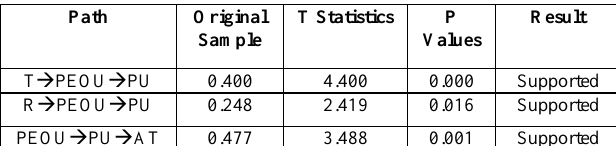
Table 4: Specific Indirect Effects